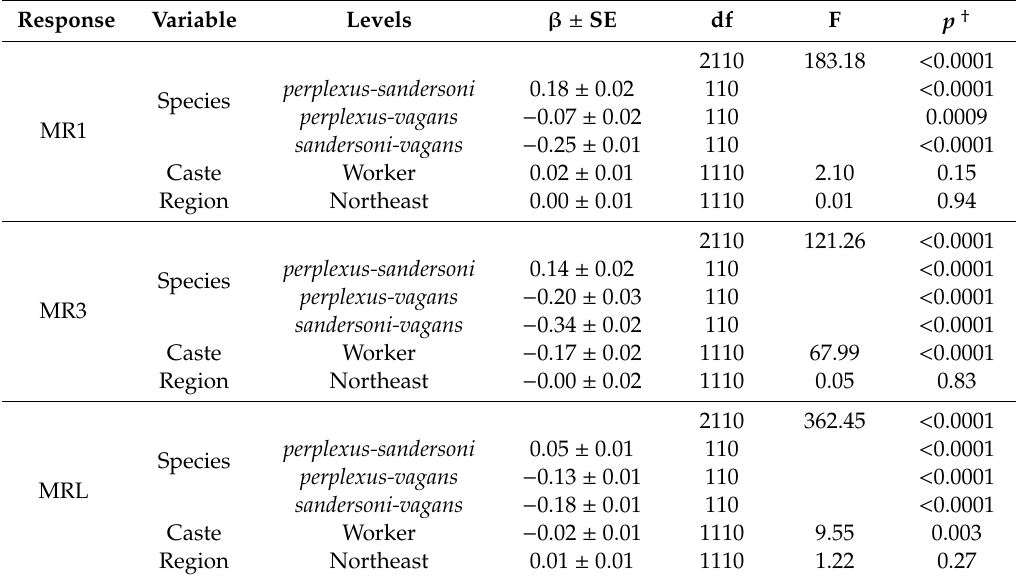
Figure 2. Statistical parsimony network highlighting the relationships of our three focal Bombus species. For each species, charts are drawn proportional to the number of sequenced individuals, and colored according to the geographic region from which individuals were collected. White circles are drawn to signify individual base pair di ff erences between haplotypes. Table 1. Results from generalized linear model (GLM), ANOVA and pairwise di ff erences of fixed e ff ects comparing the measurement means among the three species and between castes and regions. † Species comparisons are the Tukey’s HSD adjusted p